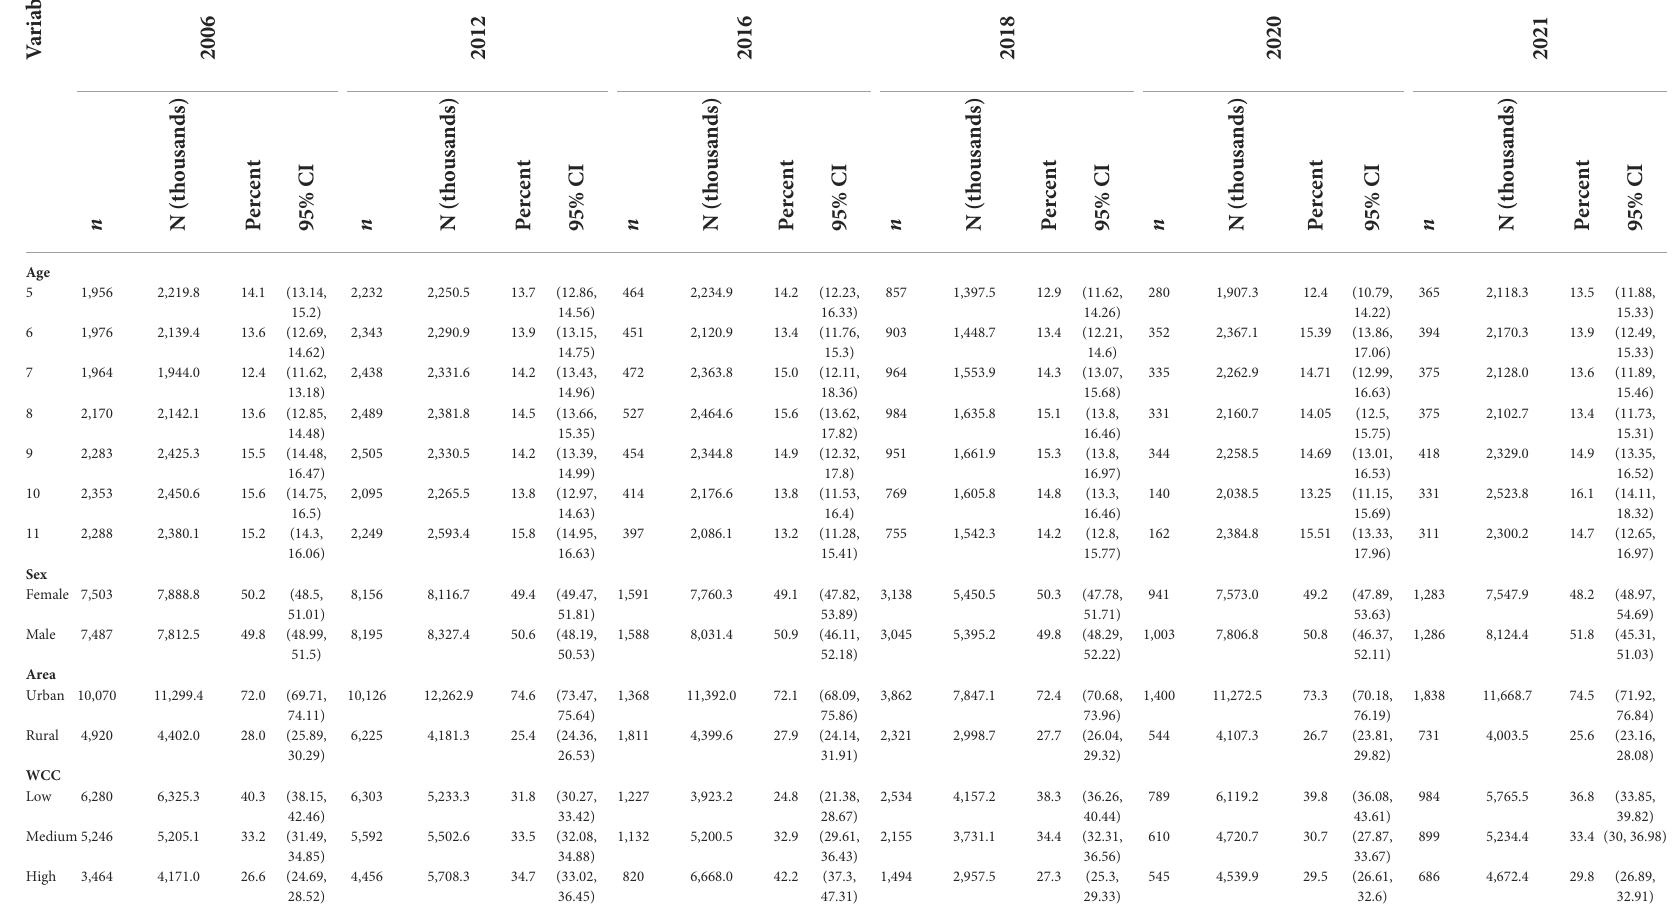
TABLE 1 Descriptive characteristics of the study